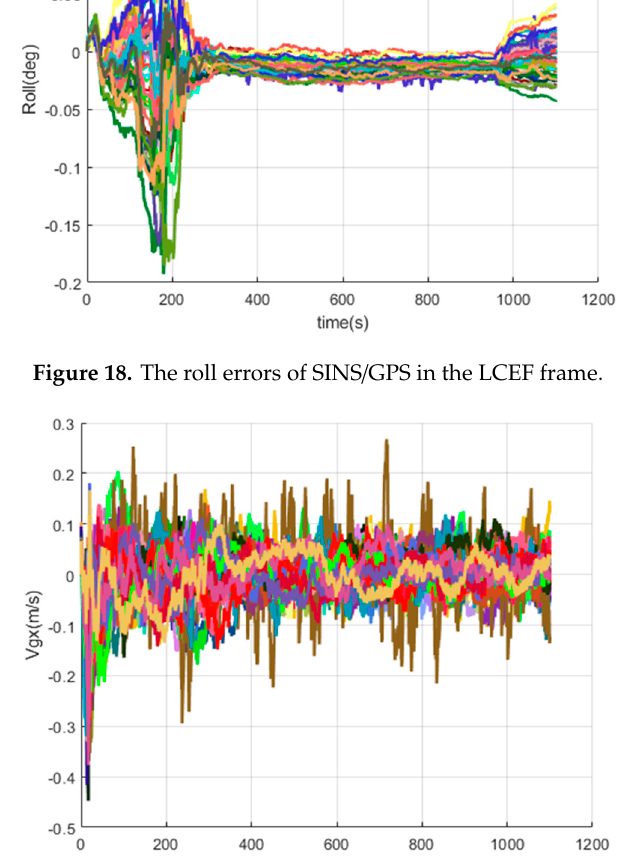
Figure 19. The x -axis velocity errors of SINS/GPS in the LCEF frame.